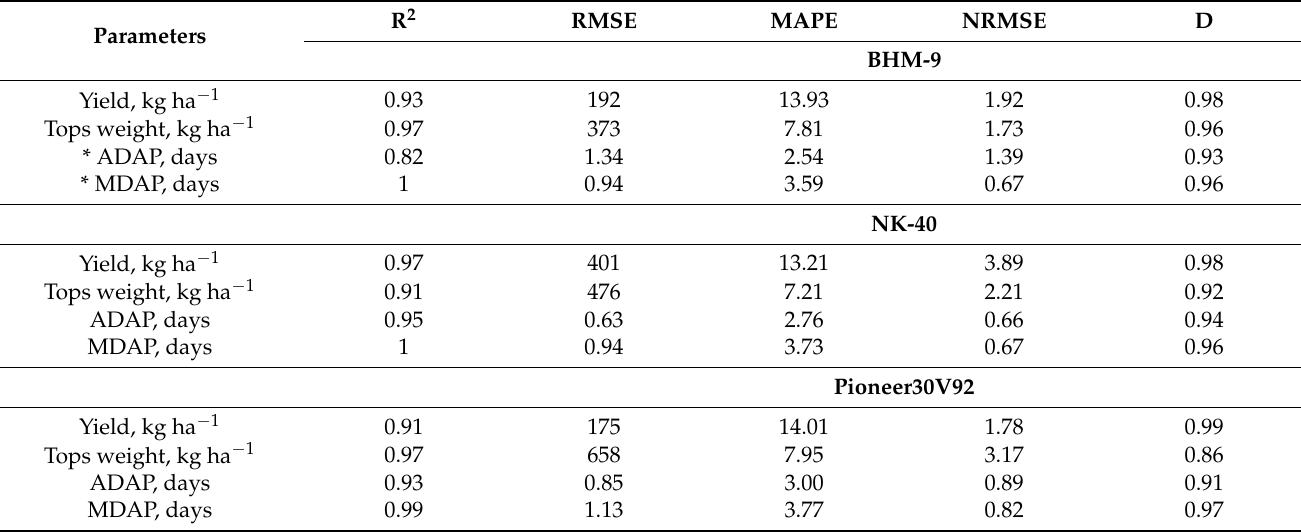
Table 5. Indicators of the goodness of fit for grain and biomass yields, and growth duration using CERES-Maize model validation irrespective of sowings dates at Rangpur, Bangladesh during 2016–2017.